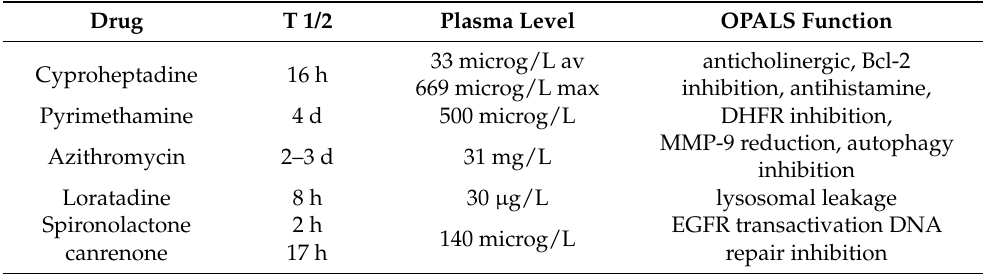
Table 1. Basic pharmacological attributes of the OPALS drugs, cyproheptadine, pyrimethamine, azithromycin, and spironolactone. T1/2 is the elimination half-life. References in text. All the OPALS drugs have empirical evidence of NSCLC and GB growth inhibition from preclinical studies. Drug T 1/2 Plasma Level OPALS Function